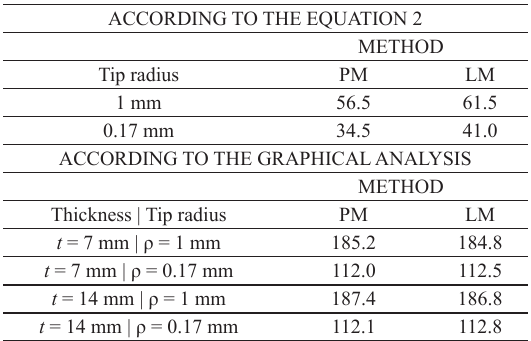
Table 6. Theoretical predictions of K ctheor. (MPa√m) for the tested specimens under bending loading.